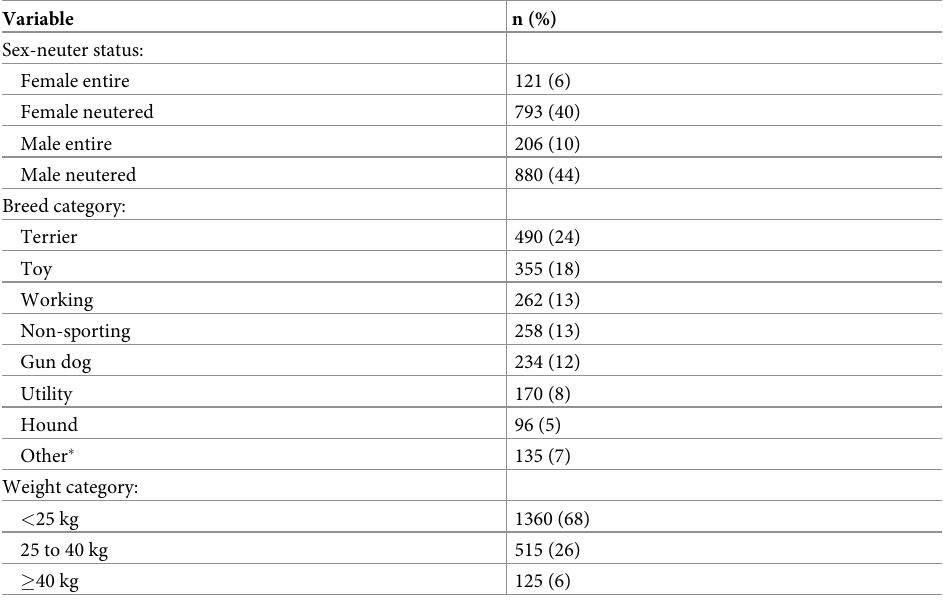
� ‘Other’: the breed listed in the patient record was either not recorded or not consistent with the Australian